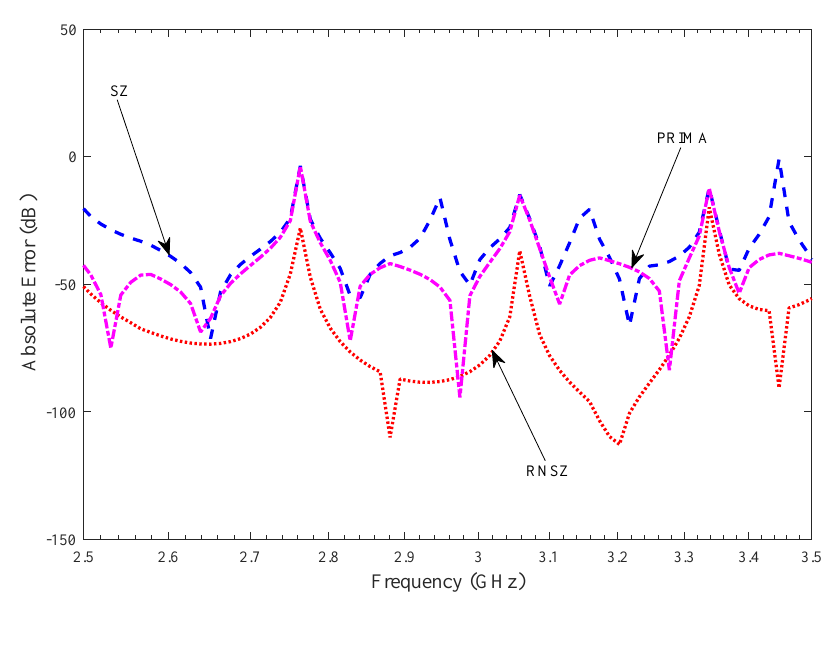
Figure 5. The absolute error plot shows minimum error for the RNSZ method. The calculated mean absolute error for the RLC network in the frequency of interest (2.5 GHz to 3.5 GHz) is − 71.64 dB, − 35.89 dB and − 44.85 dB for RNSZ, SZ and PRIMA methods